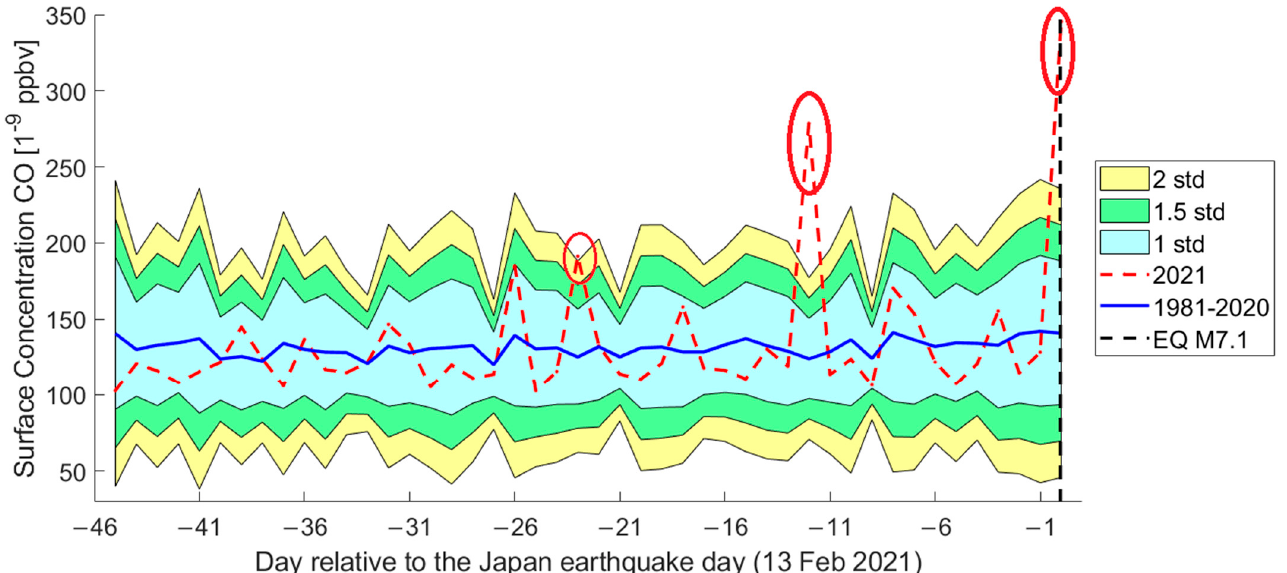
Figure 14. Atmospheric analysis of surface carbon monoxide (CO) concentration in the 45 days before the Mw = 7.1 Japan 13 February 2021 earthquake in a square area of 3° size centred on the epicentre. We highlight the anomalies with red circles, where a bold red circle means a significant and more robust anomaly.